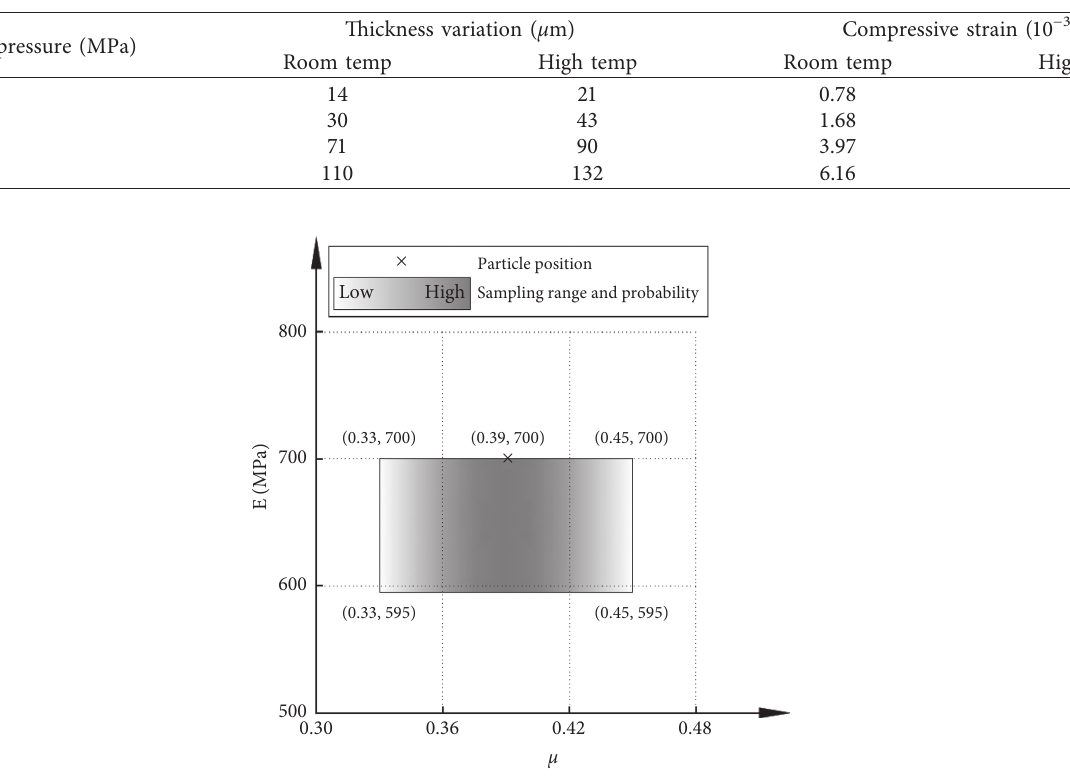
Table 5: Test results for the compressive strain of the brake lining.